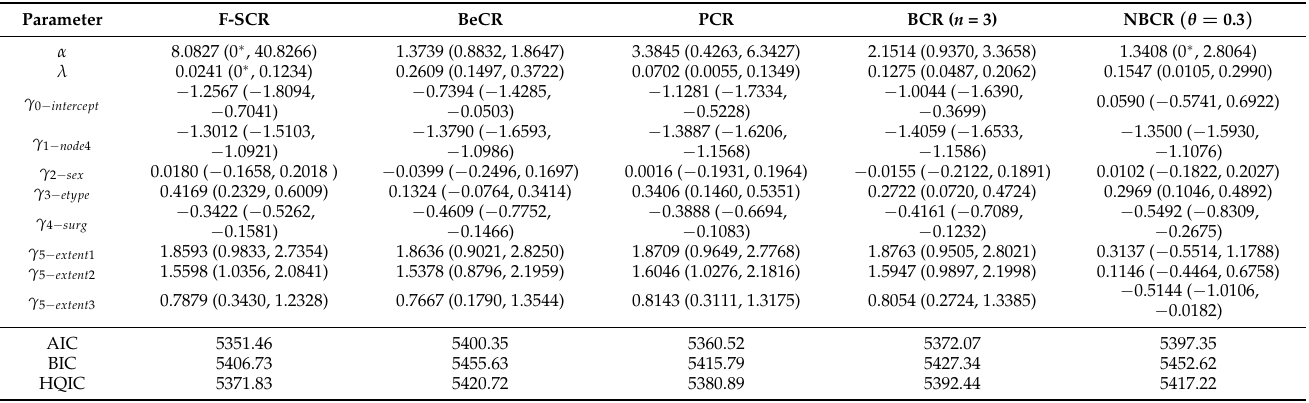
Table 2. ML estimators (95% confidence intervals) and information criteria for the colon cancer data set based on NH distribution.